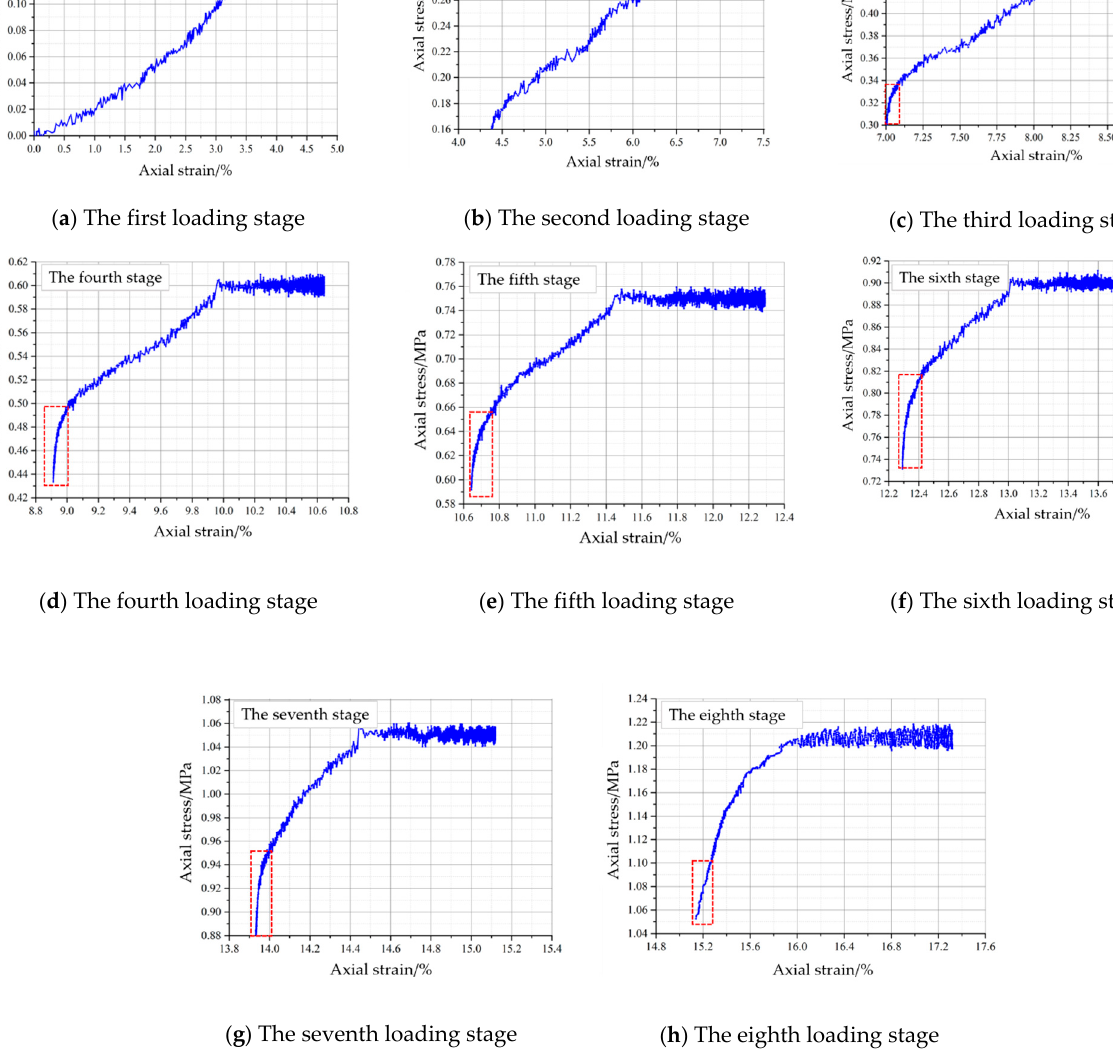
Figure 11. The periodic stress-strain curves of sample S-2 at each loading stage.